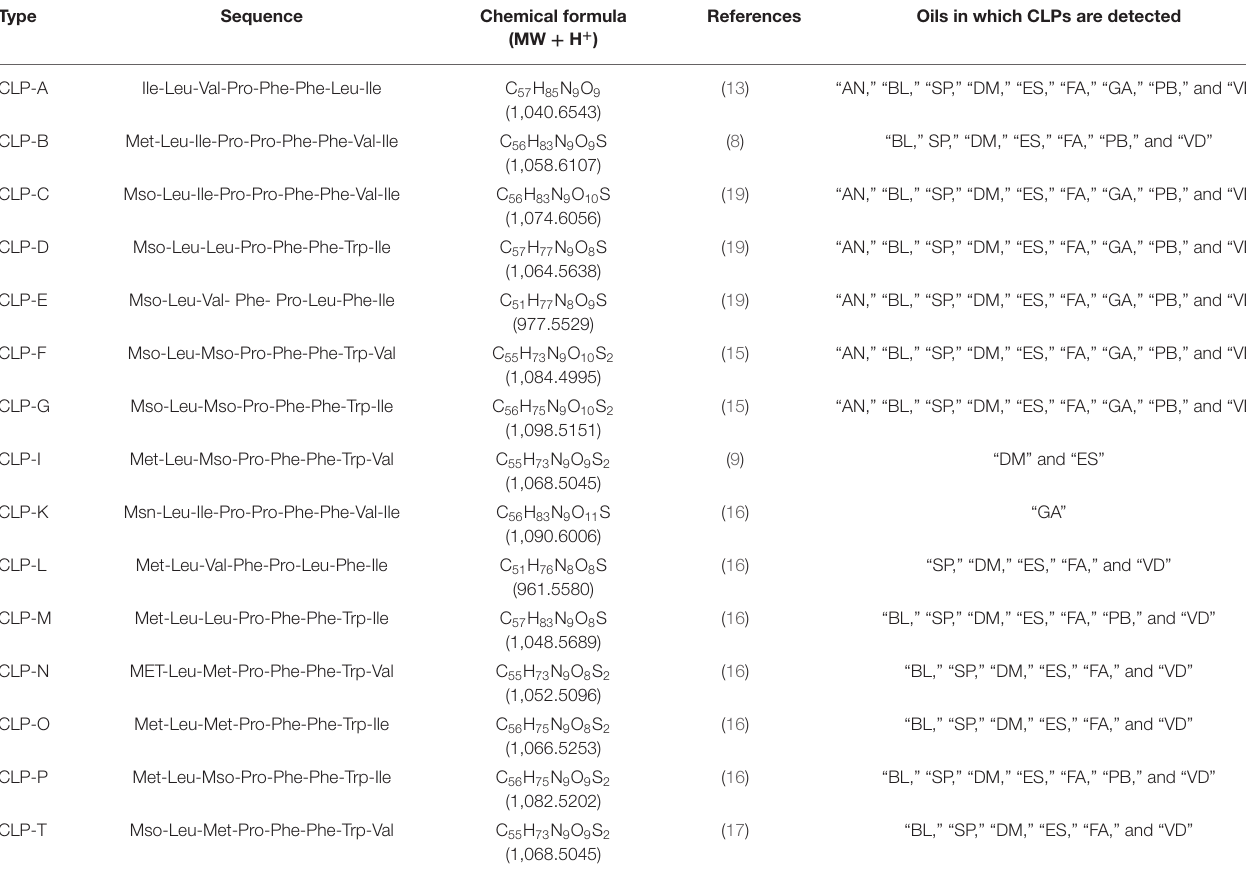
TABLE 1 | CLPs in flaxseed oil extract detected using Hybrid Quadrupole-Orbitrap Mass Spectrometer-RP